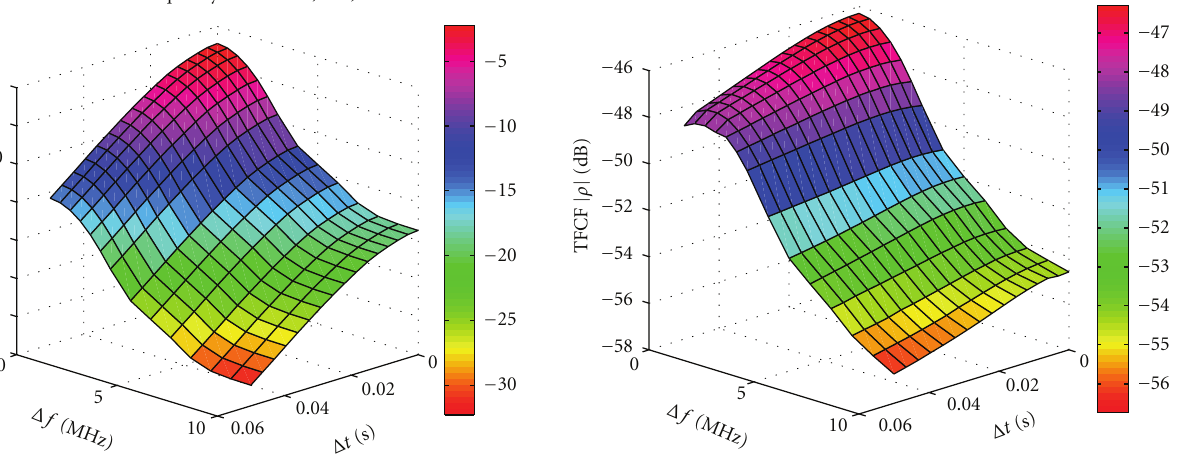
Figure 8: Normalized time-frequency correlation function of V-H link for SBT